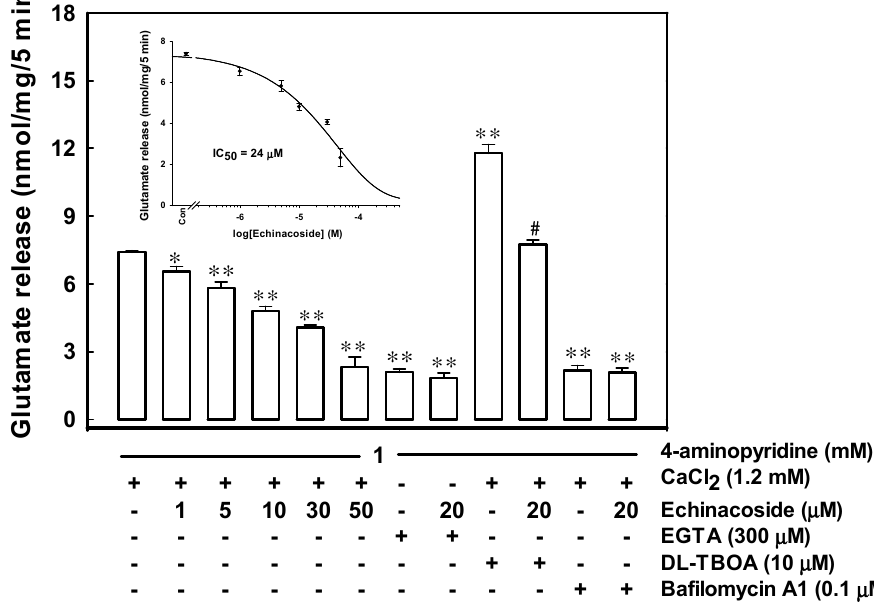
Figure 1. Echinacoside inhibits 4-aminopyridine-evoked glutamate release from rat cerebrocortical nerve terminals via the Ca 2+ -dependent exocytotic component. Glutamate release was evoked by 1 mM 4-aminopyridine in the absence (control) or presence of echinacoside (1, 5, 10, 30, and 50 µM), 300 µM ethylene glycol bis( β -aminoethyl ether)- N , N , N ′ , N ′ -tetraacetic acid (EGTA) (omitting CaCl 2 ), 300 µM EGTA (omitting CaCl 2 ) and 20 µM echinacoside, 10 µM DL -threo-beta-benzyl-oxyaspartate ( DL -TBOA), 10 µM DL -TBOA and 20 µM echinacoside, 0.1 µM bafilomycin A1, or 0.1 µM bafilomycin A1 and 20 µM echinacoside. Echinacoside was added 10 min before depolarization and, EGTA, DL -TBOA or bafilomycin A1, 20 min prior to this. Results are mean ± S.E.M. of 4–6 independent synaptosomal preparations. *, p < 0.01, **, p < 0.001 versus control group. #, p < 0.05 versus the DL -TBOA-treated group.